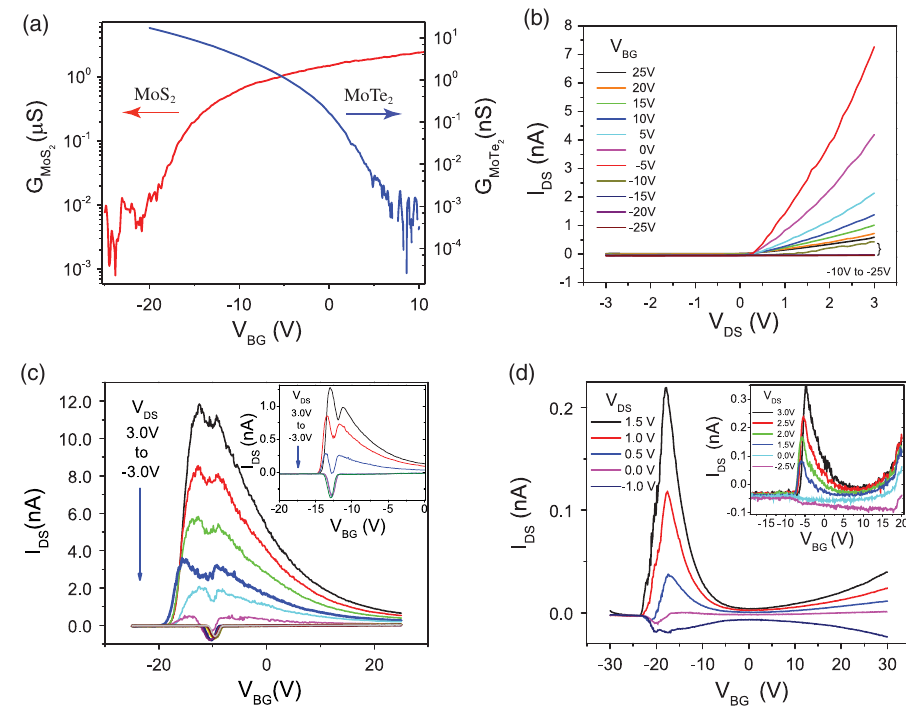
Fig. 2 a Gate response of individual MoS 2 ( red curve ) and MoTe 2 ( blue curve ) for device D 1. b I DS – V DS response of the junction. Responses for V BG − 20 V to − 5 V shows clear recti fi cation behavior. c I DS – V BG response of the junction from V DS − 3 V to +3 V in 0.5 V steps. An anomalous dip can be observed near the maximum of current in forward bias. Inset shows I DS – V BG response for device D 2. Here also similar dip can be observed. d I DS – V BG response for device D 3 and inset shows the same for device D 4. No dip was observed for D 3 and D